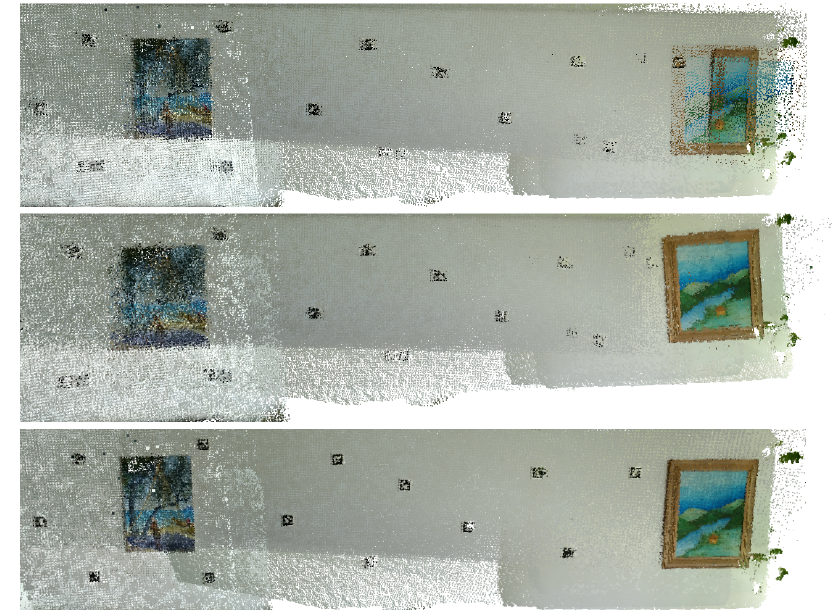
Figure 20. MeetingRoom dataset coloured with texture obtained from original images (detail 1): ( top ) Google Tango; ( middle ) ICP; ( bottom ) Our approach.